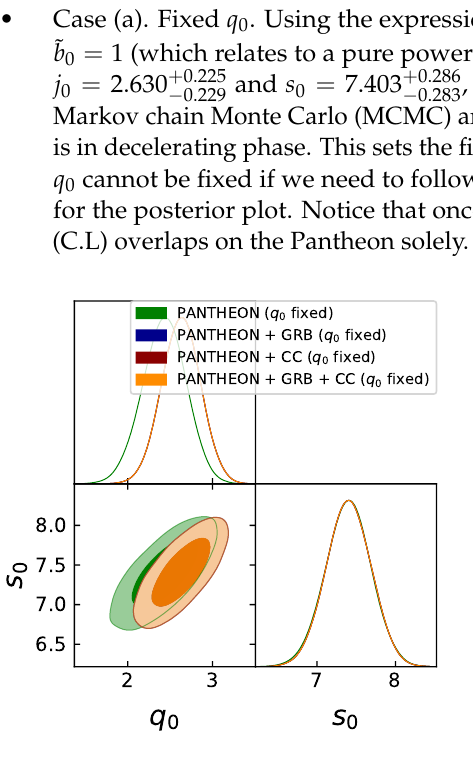
Figure 1. Case (a) using Pantheon compilation (green C.L.), Pantheon+GRB (blue C.L.), Pantheon+CC (red C.L.) and Pantheon+GRB+CC (orange C.L.).